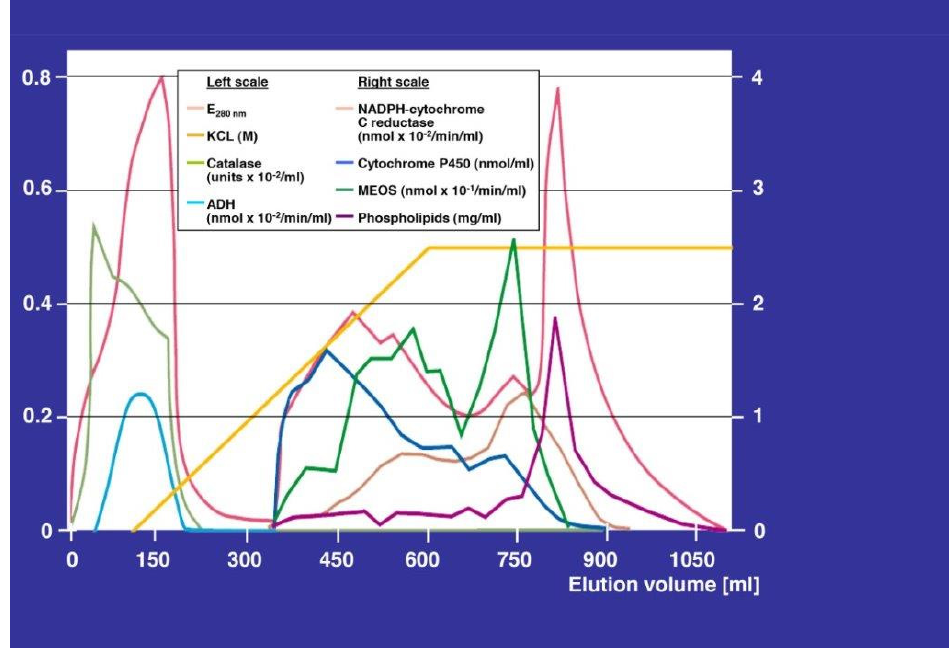
Figure 1. The elution pattern with separation of the MEOS from catalase and ADH activities. Using ion exchange DEAE column chromatography and a continuous KCl grading starting with 0 and increasing up to 0.5 M KCl (bright yellow), eluates started with the void volume recovered up to around 220 mL. The highest peak represents the protein curve (light red) assessed as E 280nm. The left-sided peak below represents the catalase peak. ADH is the lowest peak. Starting with an elution volume at 330 mL, the microsomal components appears. Cytochrome P450 (blue) can be seen around 440 mL that decreases in the further course up to 900 mL, the second peak at 500 mL represents E 280nm (light red), followed by a third peak at 580 mL with two shoulders, and by a fourth peak at 740 mL representing MEOS (green). At 750 mL, the reductase peak emerges (light violet), followed by the phospholipids peak (dark violet) at 790 mL elution volume. Modified from the original figure published in a previous report [8].